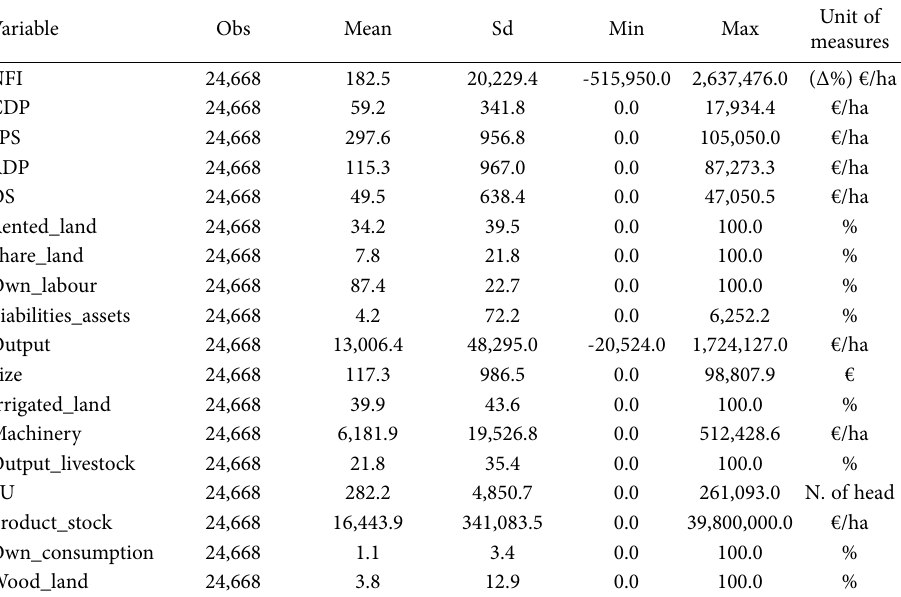
Table A. Descriptive statistics of